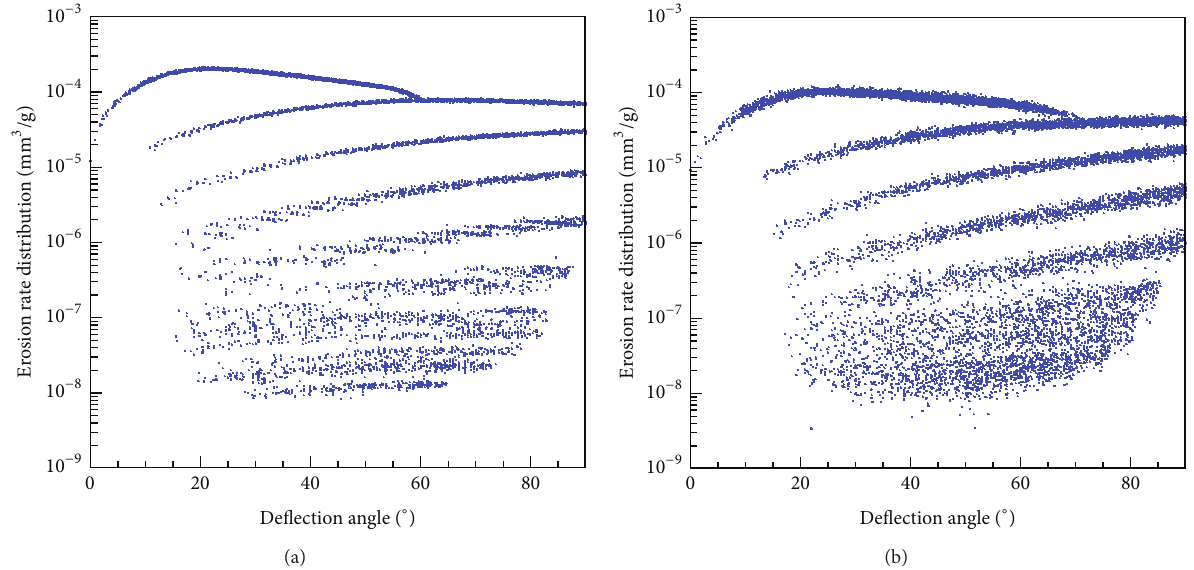
Figure 4: Erosion rate 𝐸 V distribution per impact particle against the deflection angle of curved duct at the inlet velocity 5.3 m/s: (a) particle diameter 200 𝜇 m and (b) particle diameter 100 𝜇